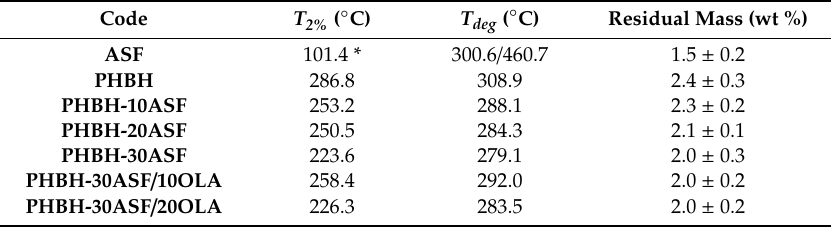
Table 4. Summary of the main thermal degradation parameters of PHBH-ASF / OLA composites with di ff erent compositions, in terms of onset degradation temperature ( T 2% ), temperature of maximum degradation ( T max ), and residual mass at 700 ◦